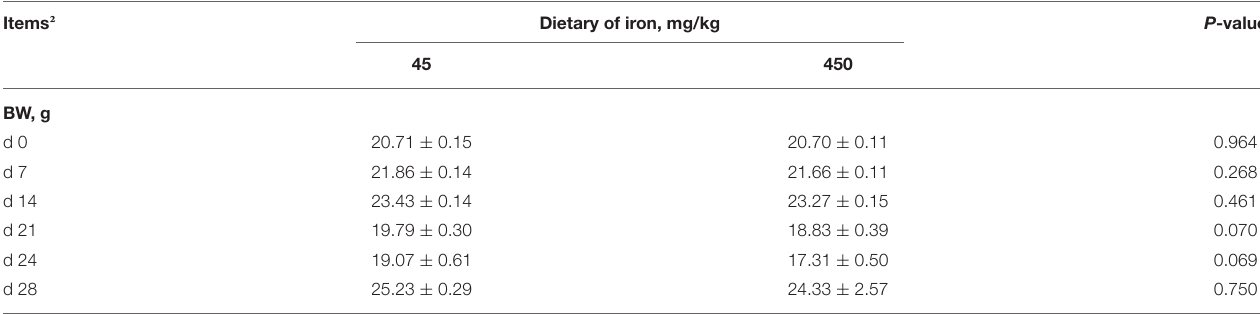
TABLE 1 | The effect of iron in the diet on the body weight of adult mice¹. Items ² Dietary of iron, mg/kg P -value